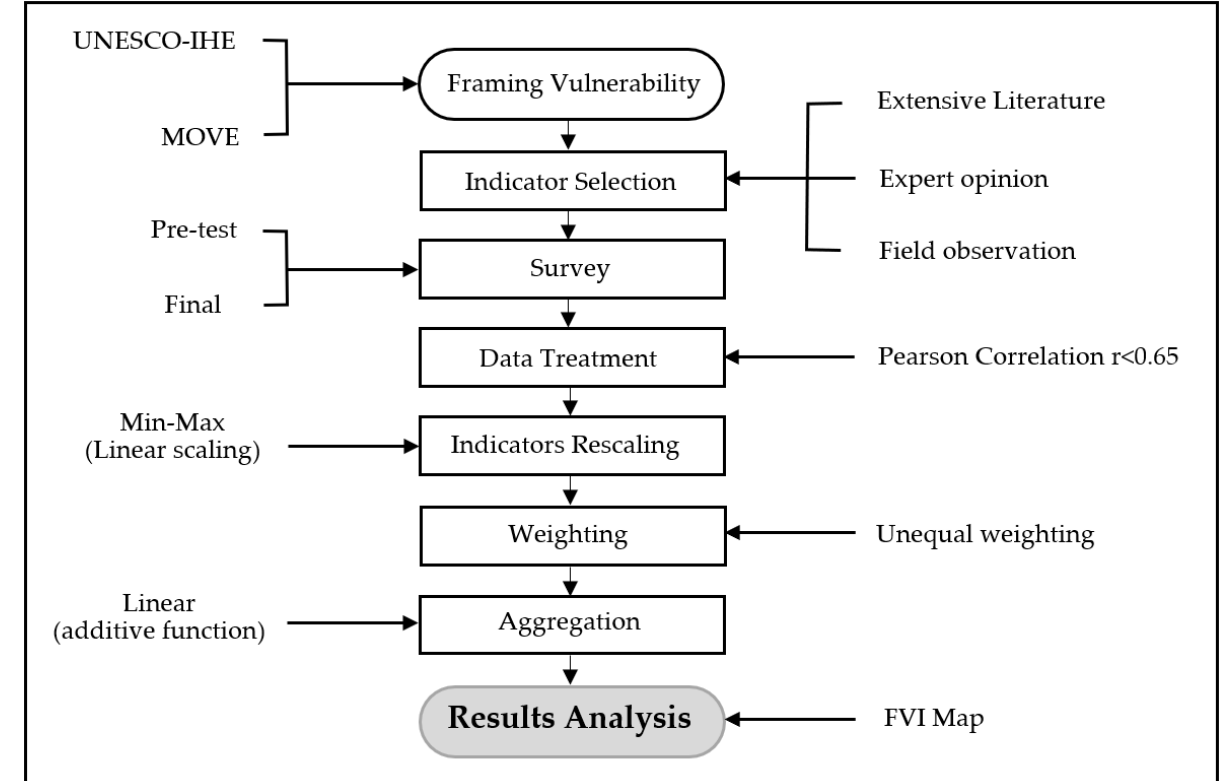
Figure 2. Flood vulnerability indices’ development workflow. Adapted from